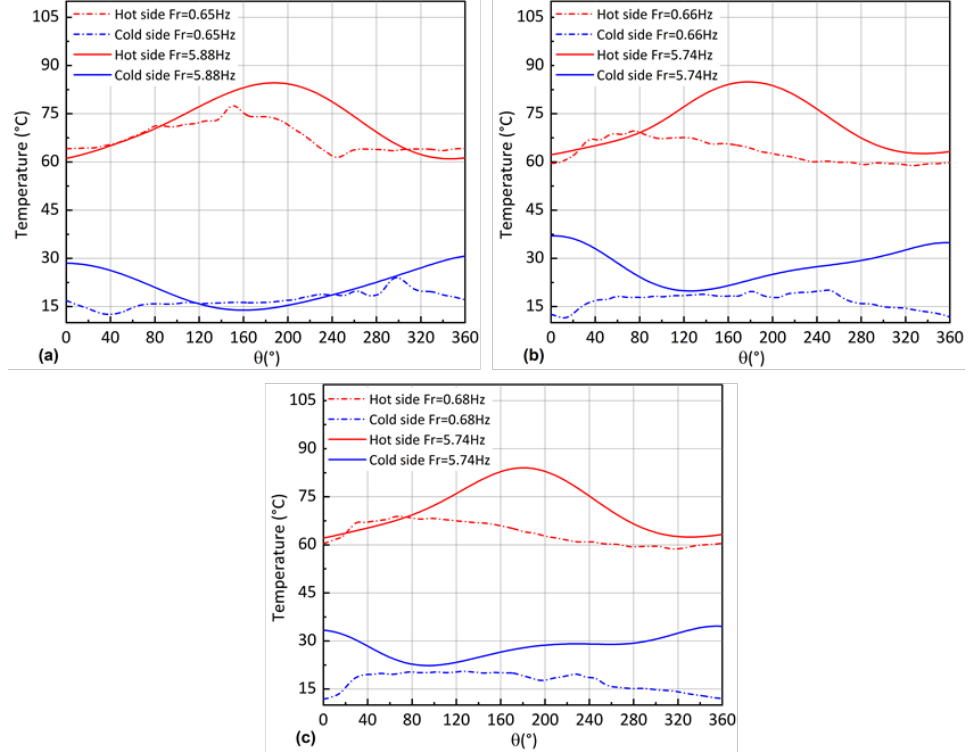
Figure 7. Evolution of temperatures at hot and cold inlet sides of regenerator (( a ): Str_30%, ( b ): Str_35%, ( c ): Str_40%. L 1 = 60 mm, C 1 = 64.4 mm) versus phase for temperature gradient Δ T 1 = 70 °C/10 °C.